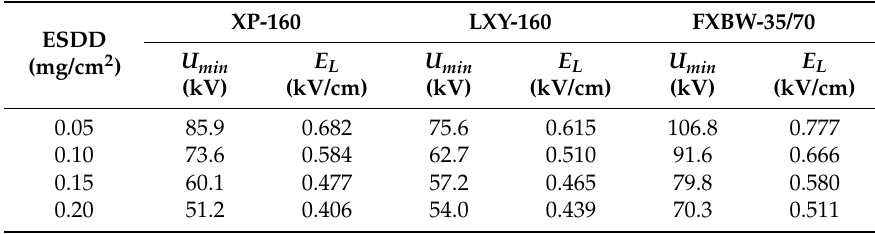
Table 2. Alternating current (AC) arc flashover gradient of snow-covered insulator strings under different equivalent salt deposit density (ESDD) .